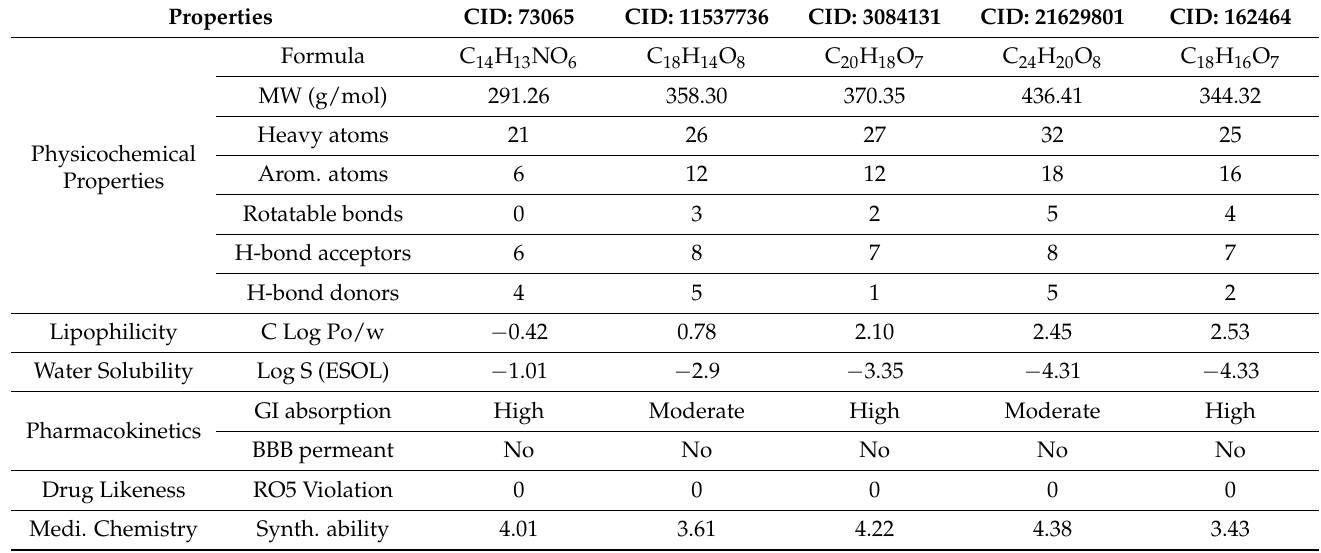
Table 2. List of pharmacokinetic properties, including ADME properties, of the five selected natural compounds. The list also includes the different physicochemical properties of the compounds.